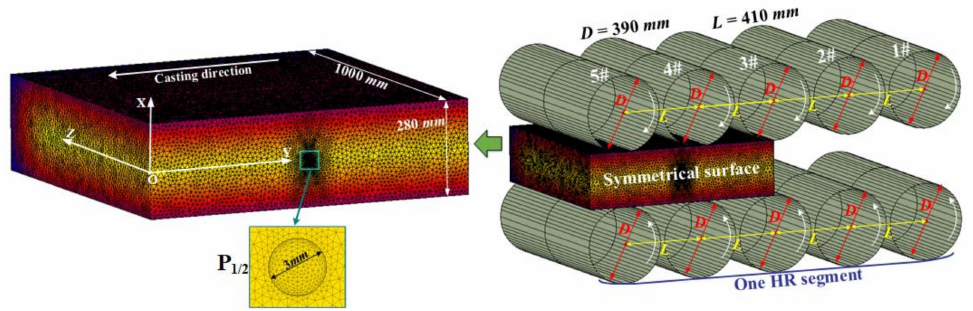
Figure 2. Schematic of the three-dimensional (3D) thermal-mechanical coupled